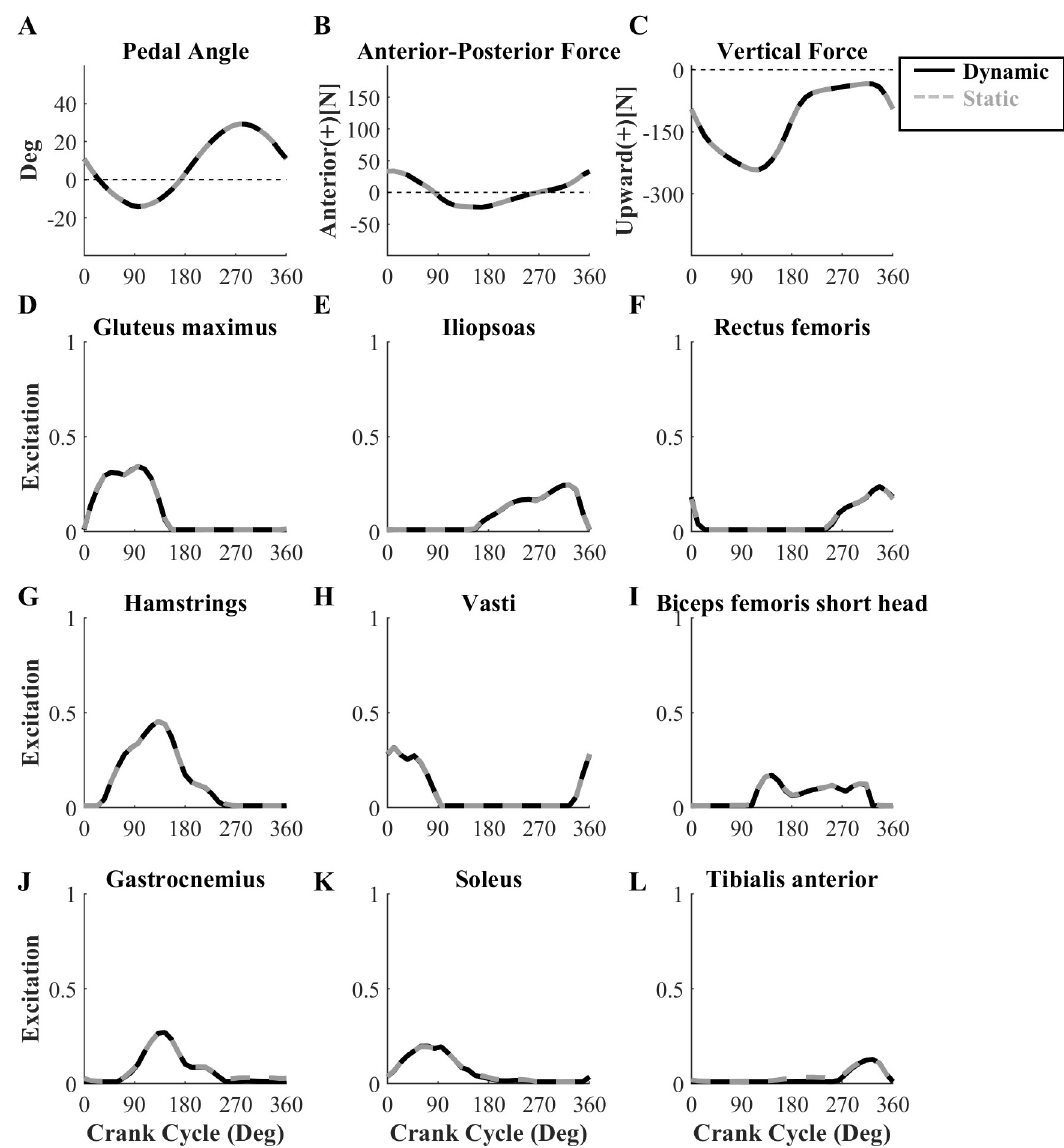
Fig 6. Simulated pedal angles, pedal forces, and MTU excitation patterns using two different initial guesses. Simulated pedal angles (A), pedal forces (B-C), and MTU excitation patterns (D-L) found with dynamic ( black solid line ) and static ( light gray dotted line ) initial guesses. Initial states and controls were generated from OpenSim forward simulations with manually input MTU excitation patterns for the dynamic initial guess, but were the same for all nodes (i.e. no movement, constant activation) for the static initial guess. The simulated results for the two initial guesses were almost identical, but the optimized solution started from the dynamic initial guess was obtained in less time.